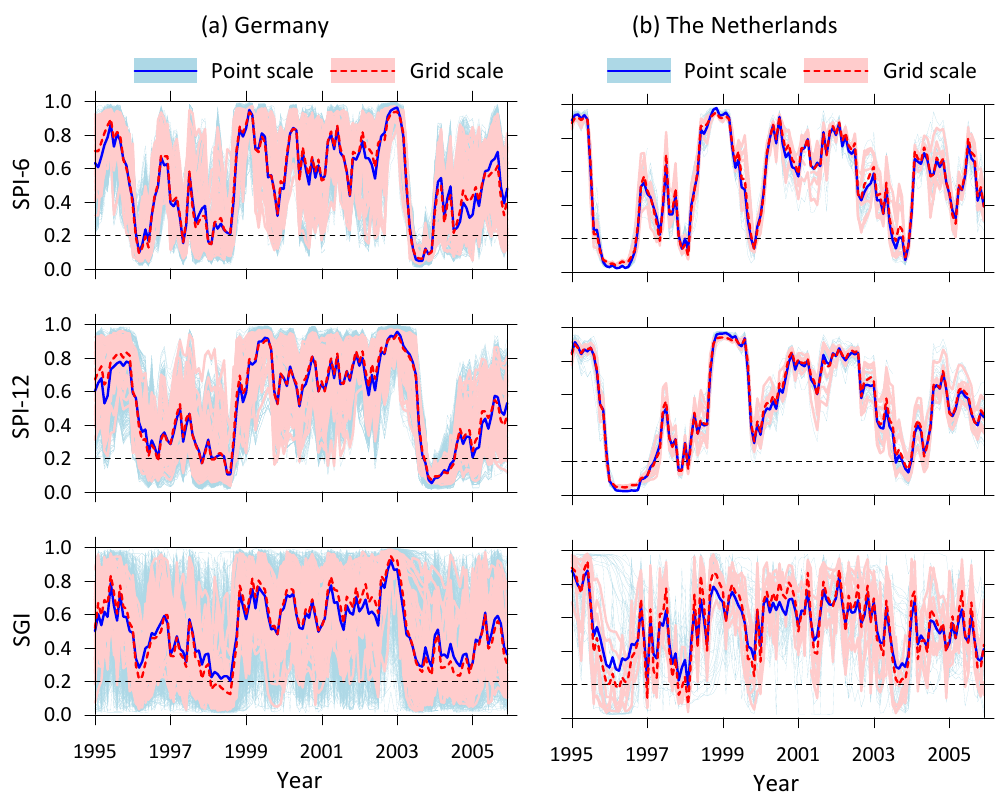
Figure 5. The monthly time series of the 6- and 12-month point (light blue) and gridded (light pink) SPI and the respective spatial averages (dark blue and dark red) for (a) German and (b) Dutch data sets. The bottom plots are the corresponding SGI time series and their spatial averages. The black dashed line depicts the drought threshold τ of